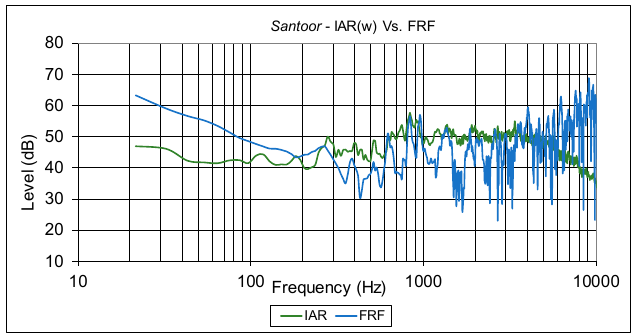
Figure 8. IAR compared with the FFR for the Persian santoor.